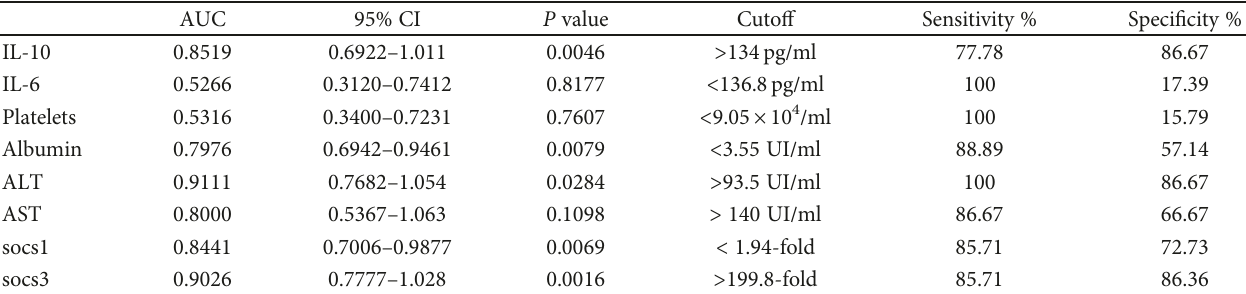
Table 3: Potential biomarkers to identify severity of dengue infection.